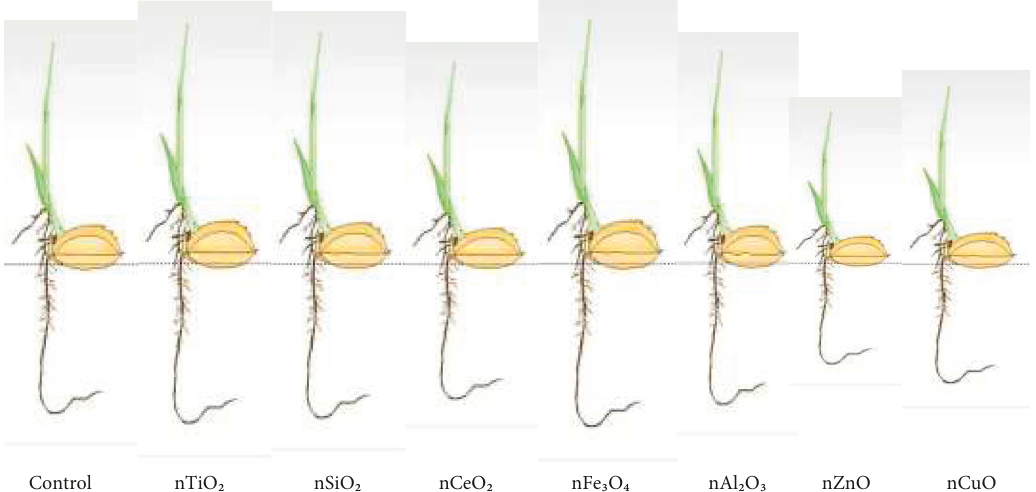
Figure 10: Comparison photos of root elongation on the 5th and 7th day of germination of rice seeds under different nanomaterial